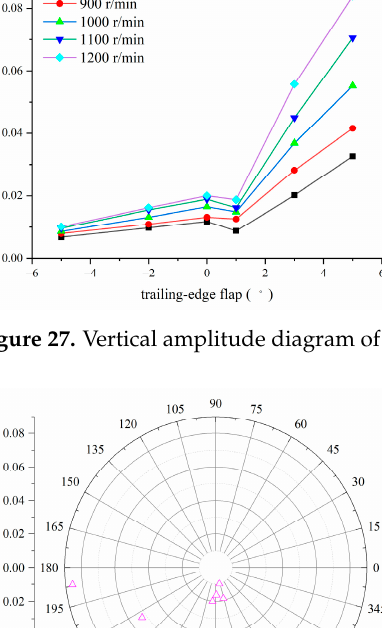
Figure 26. Longitudinal polar diagram of trailing-edge flap.